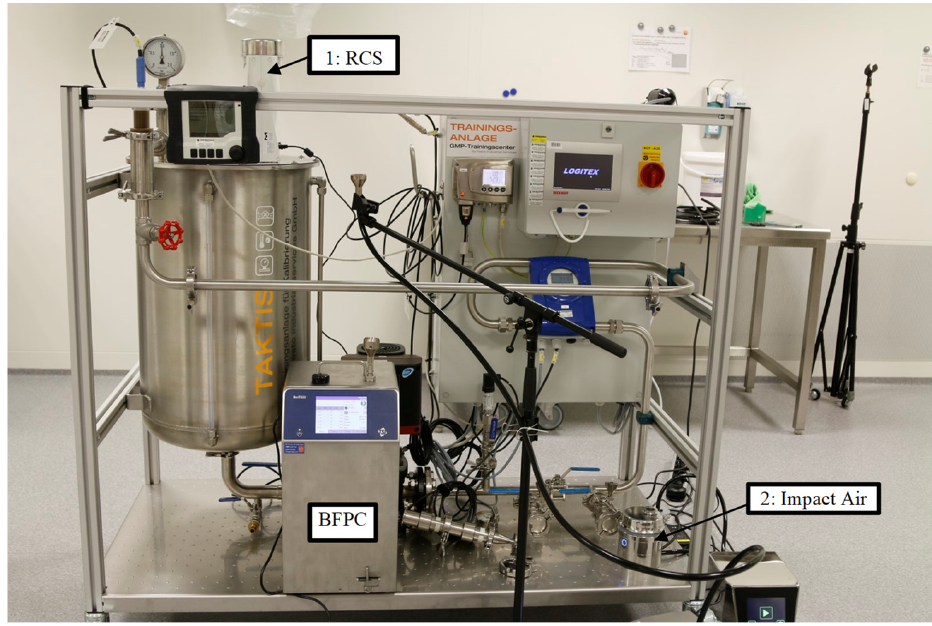
Figure 3. Process Equipment and Measuring